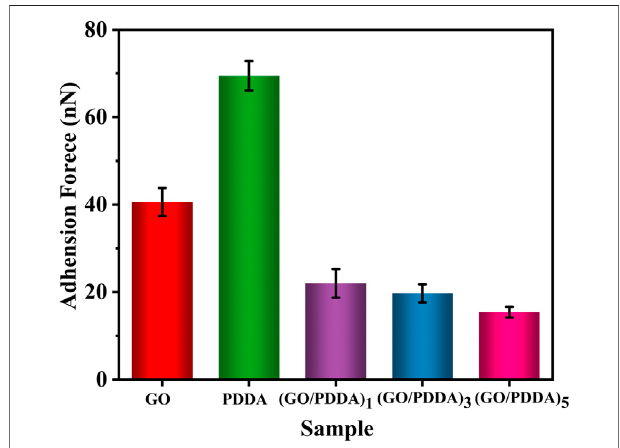
FIGURE 6 | Adhesive forces for different